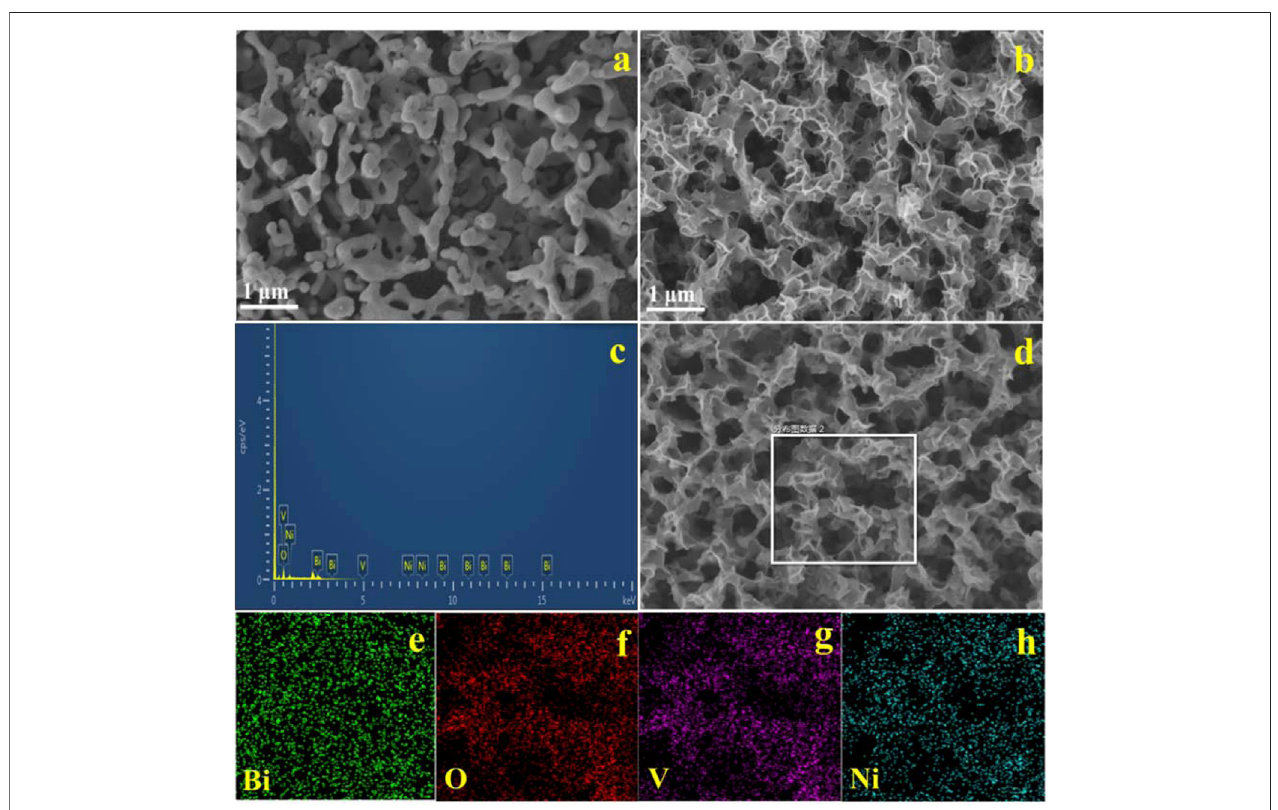
FIGURE 1 | SEM images of the typical samples: (A) BiVO photoanode.